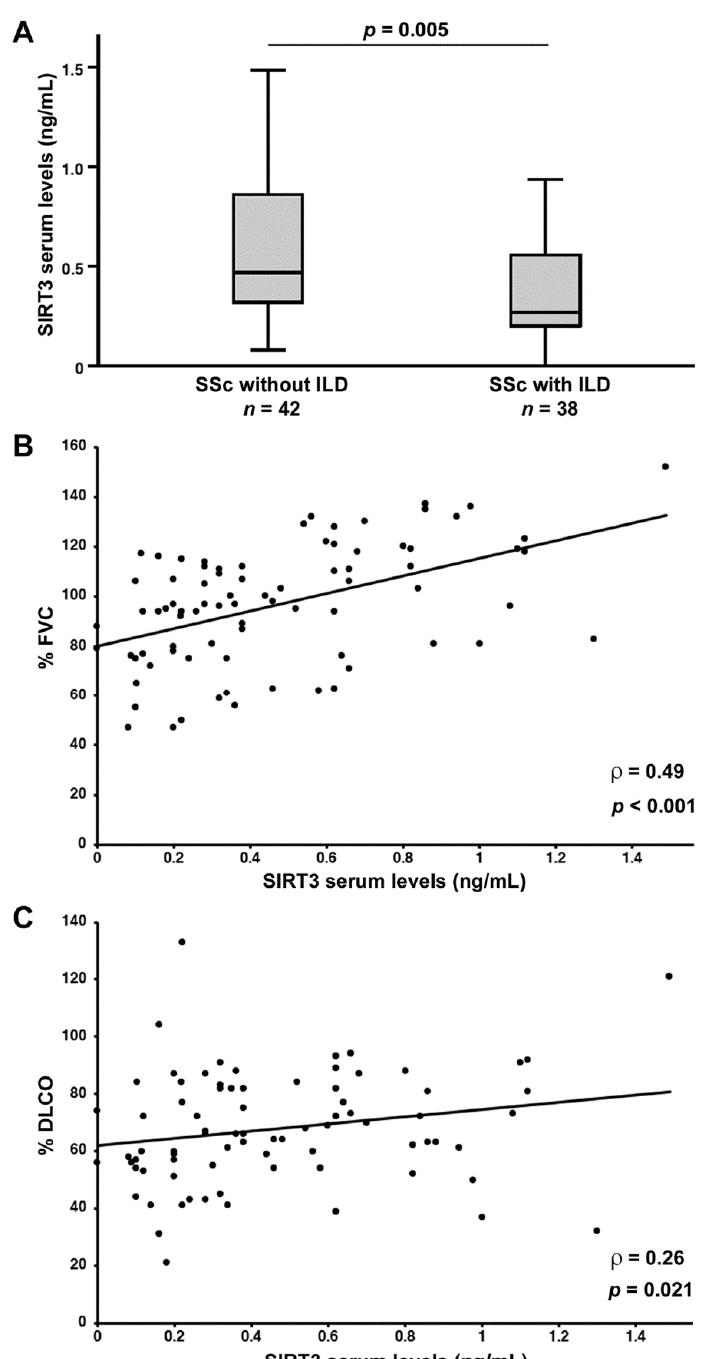
Figure 5. ( A ) Decreased serum levels of sirtuin 3 (SIRT3) in systemic sclerosis (SSc) patients with features of interstitial lung disease (ILD) on high-resolution computed tomography scan of the chest. Data are presented as box plots. Each box denotes the 25th to 75th percentiles. Lines outside the boxes are the 10th and 90th percentiles. Lines inside the boxes denote the median, circles denote the outliers, and asterisks denote the extreme values. ( B ) Correlation of serum SIRT3 levels with pulmonary function measured as percentage forced vital capacity (%FVC) in patients with SSc. ( C ) Correlation of serum SIRT3 levels with percentage diffusing capacity of the lungs for carbon monoxide (%DLCO) in patients with SSc. Data are displayed as scatterplot, where each dot represents a patient. Correlation coefficient ( ρ ) and p values are indicated.